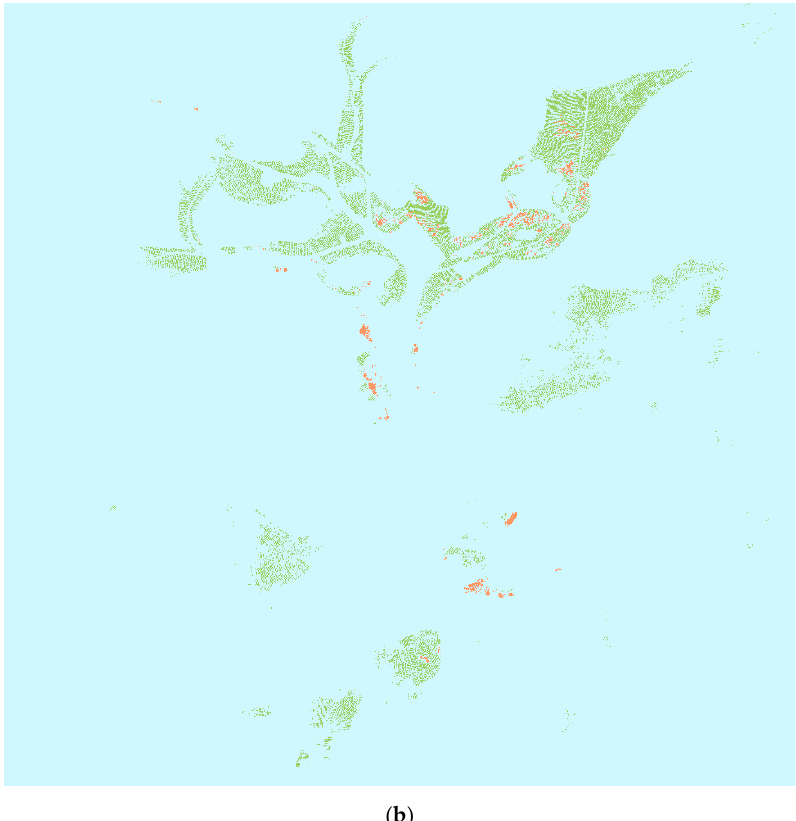
Figure 8. The extraction results of aquaculture areas in Sansha Bay and Luoyuan Bay and their adjacent waters in 2021: ( a ) Sentienl_2 MSI images of the study area in 2021; ( b ) the extraction results of aquaculture areas with the improved U-Net model, where blue is the background area including offshore land and sea, green is the extraction result of the floating raft aquaculture area, and orange is the extraction result of the cage aquaculture area.